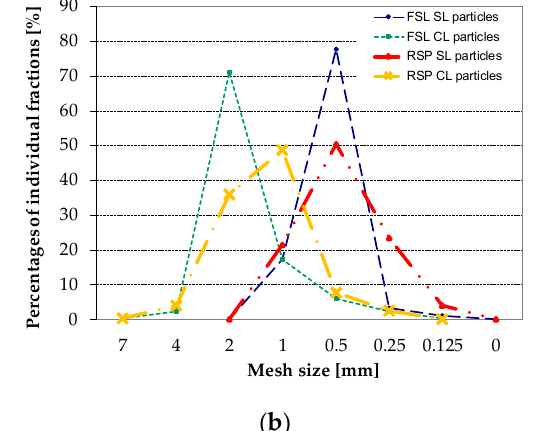
Figure 2. Particles for PBs: ( a ) Prepared from the fresh spruce logs (FSL)—type I., and from the recycled spruce pallets (RSP)—type II., at which both particle types were used in the surface layers (SL) and the core layer (CL) of PBs; ( b ) Size characteristics of particles from FSL and RSP, with percentage of individual fractions for surface layers (SL) and core layer (CL).